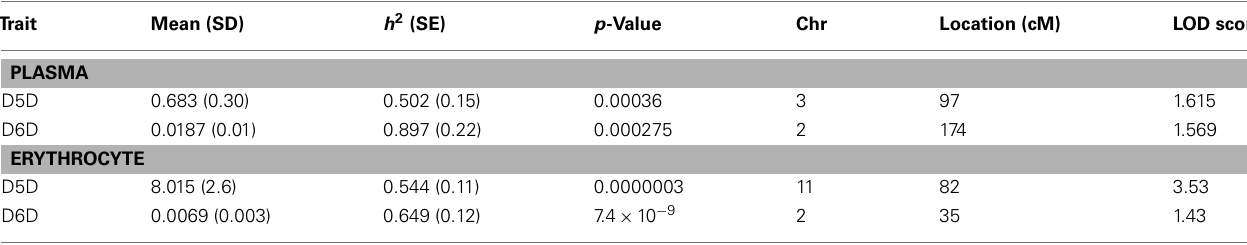
Table 1 | Heritabilities and linkage results for D5D and